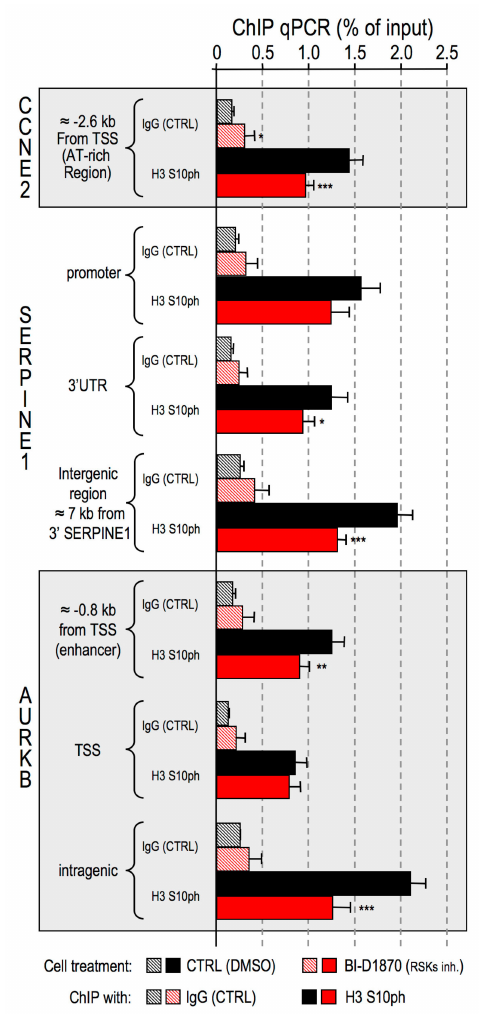
Figure 5. Ribosomal protein S6 kinase alpha-3 (RSK2) is responsible for H3S10 phosphorylation at the level of genes that are transcriptionally modulated by High Mobility Group A1 (HMGA1). Chromatin immunoprecipitation (ChIP)-qPCR experiments performed on MDA-MB-231 cells treated with the RSK2 inhibitor BI-D1870. Cell lysates from control and BI–D1870–treated cells were immunoprecipitated both with α –histone H3S10ph antibody and non-specific immunoglobulins (IgG) as a control (CTRL). Immunoprecipitated DNA was amplified with primers targeting the indicated genomic region within three HMGA1 target genes (G1 / S-specific cyclin E2, CCNE2;